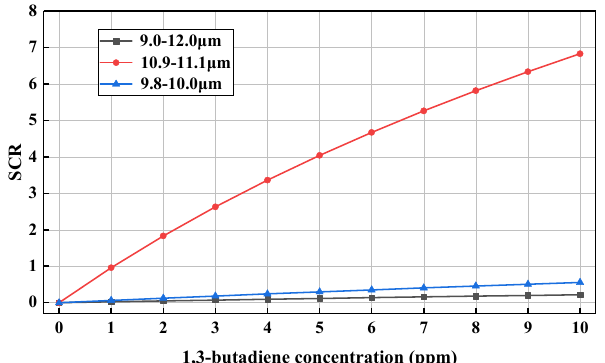
Figure 7. The relationship between the SCR and concentration.